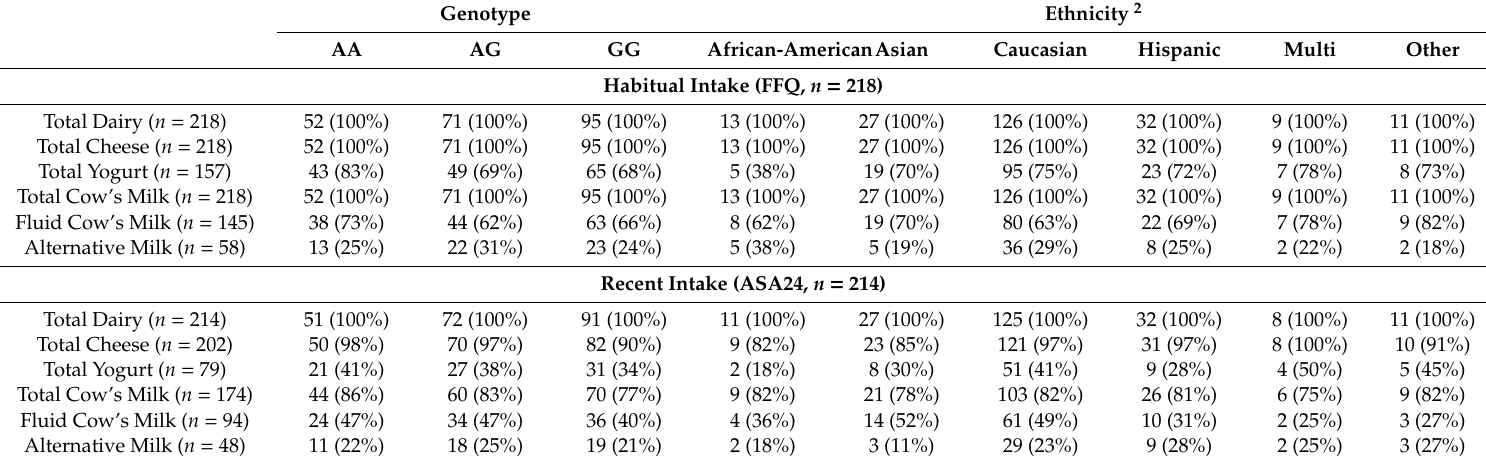
Table 2. The number of consumers ( n (%)) per genotype and ethnicity for each product 1 .